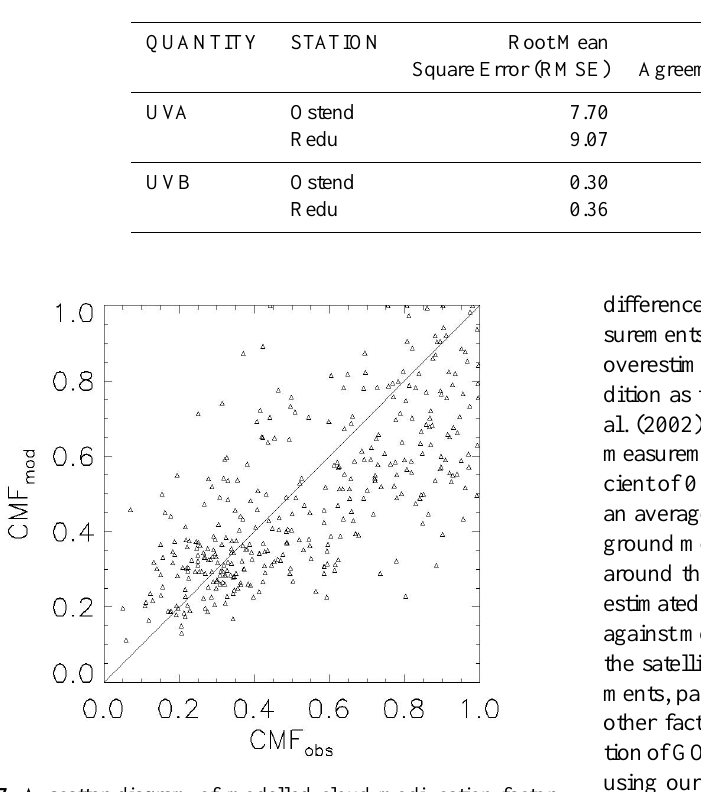
Fig. 7. A scatter diagram of modelled cloud modification factor (CMF mod ) versus observed cloud modification factor (CMF obs ) over Ostend during June